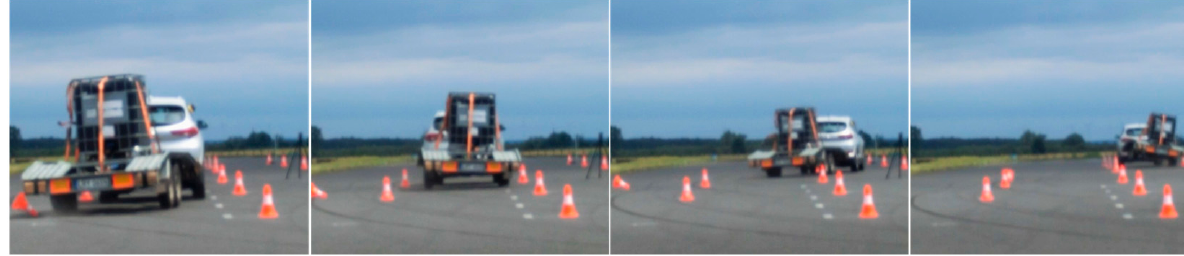
Figure 9. Experimental tests.